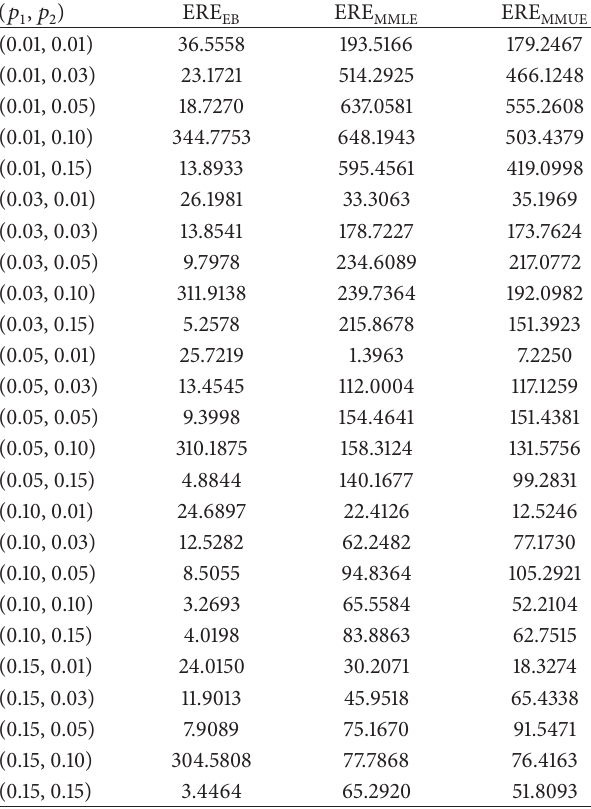
Table 5: The percentages of the Estimated Relative Error of odds ratio estimation for (𝑛 1 , 𝑛 2 ) =